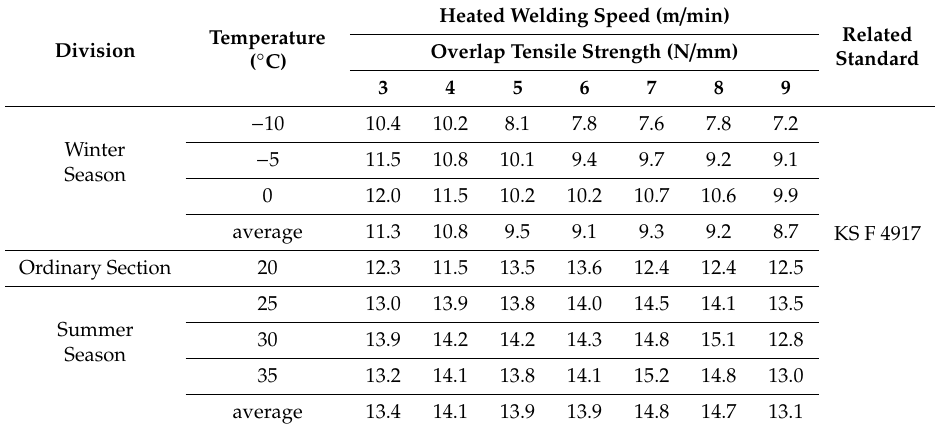
Table 6. Joint tensile strengths under di ff erent hot air welding speeds and temperature conditions.